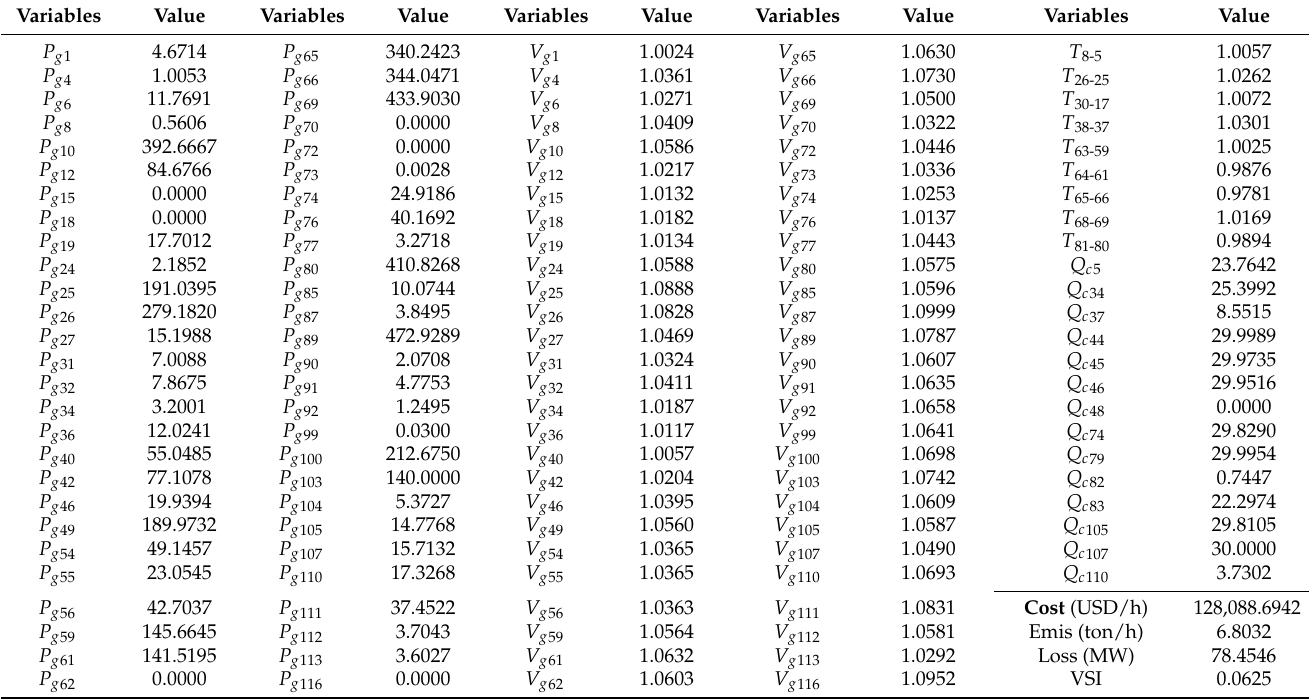
Table A2. Optimal solutions provided by MaMPA when considering cost as the objective function in the IEEE 118-bus system (case